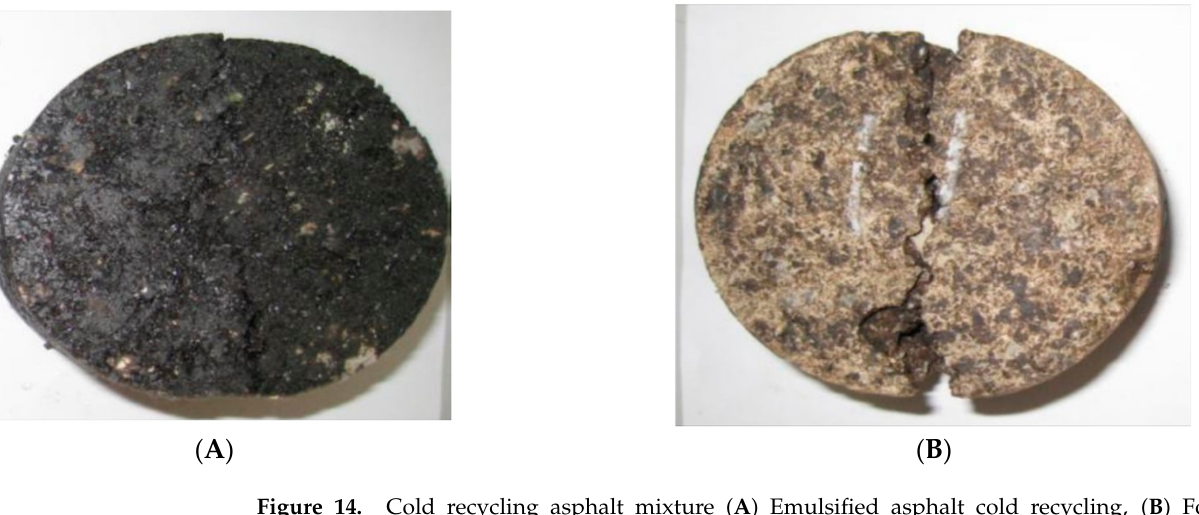
Figure 13. Comparison of master curve parameters (A/ ω , δ 0 ) of phase angle.